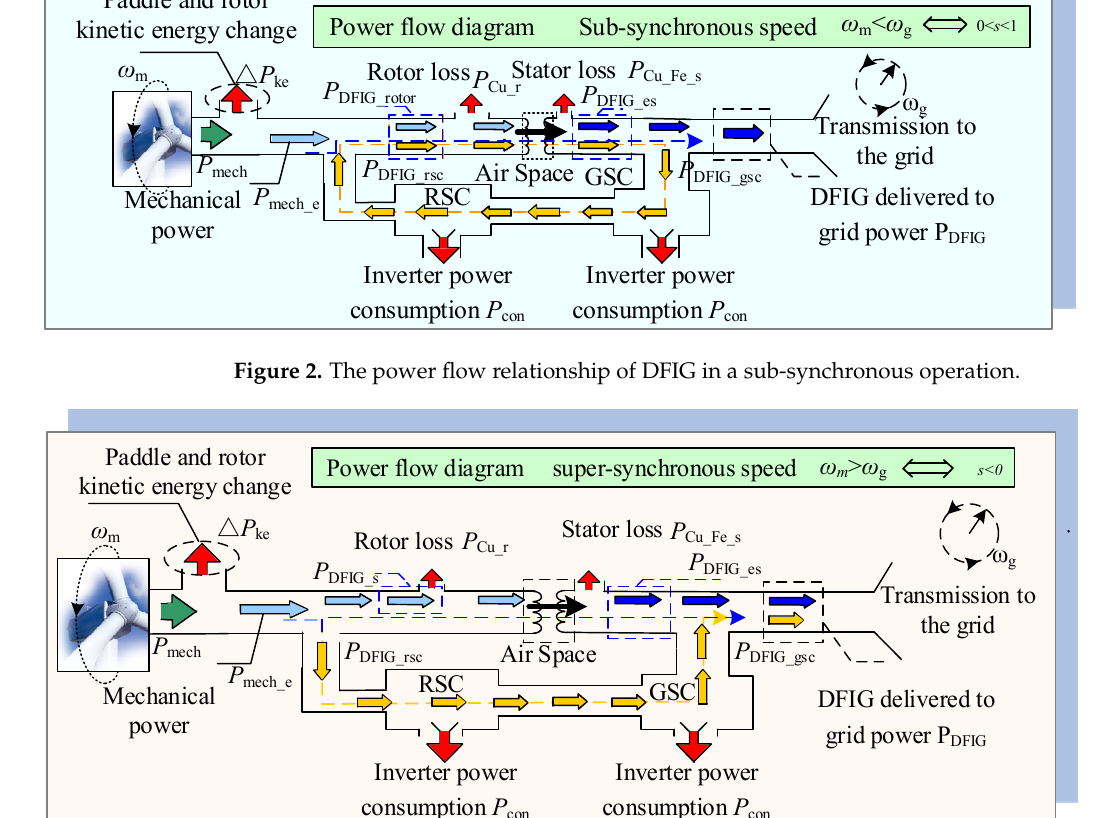
Figure 2. The power flow relationship of DFIG in a sub-synchronous operation.